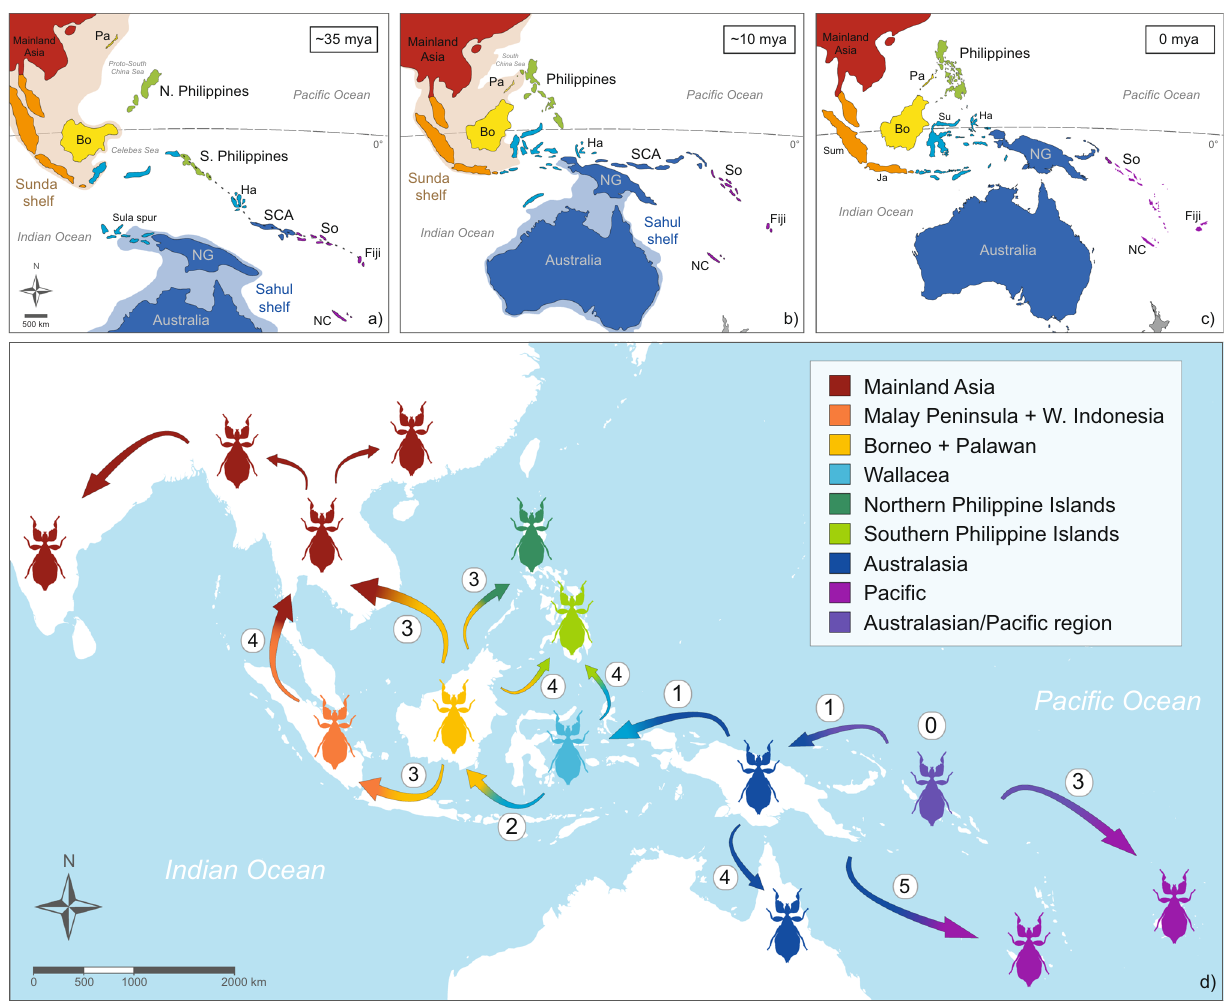
Fig. 6 Schematic overview of the historical biogeography of Phylliidae. a – c Palaeogeography of SE Asia and the SW Paci fi c (adapted from Hall 72 ) showing the northward movement of the Sahul shelf and the drift of the fragments of the Philippines and Wallacea. The dotted line in ( a ) indicates which landmasses will be connected via the Vitiaz arc (~30 mya). Note that the depiction of landmasses does not necessarily imply that they were emergent at that time. Both Sunda and Sahul shelves may have been exposed as dry land during low sea – level stands. d Main dispersal events of extant leaf insects with origin in the Australasian/Paci fi c region (0). The numbering illustrates our suggested chronological order of colonisation. Colour code corresponds to Fig. 5. Bo Borneo, Ha Halmahera, Ja Java, Pa Palawan, NC New Caledonia, NG New Guinea, SCA South Caroline arc, So Solomon Islands, Su Sulawesi, Sum